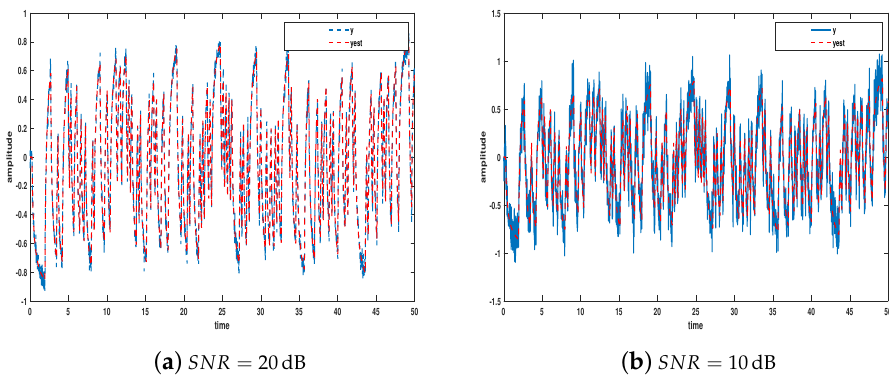
Figure 4. The true and the estimated output signals of example 1.